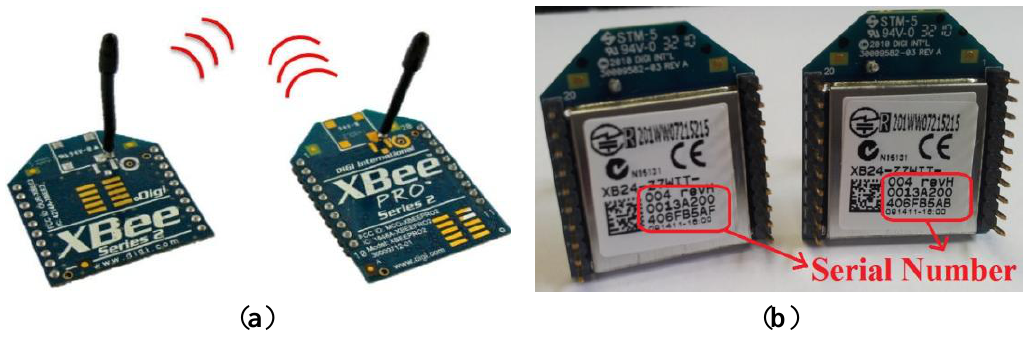
Figure 4. ZigBee modules. ( a ) Antenna on top; ( b ) Network hardware ID on the